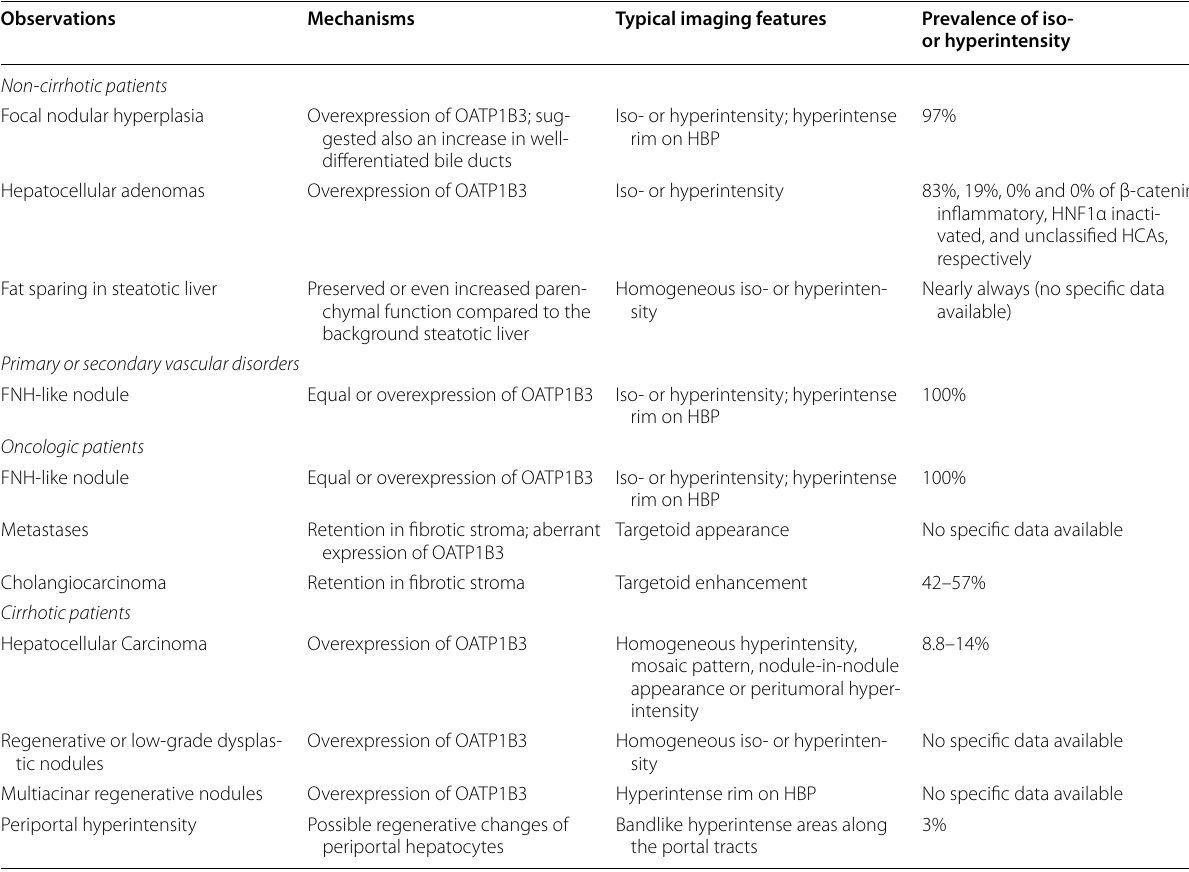
Table 1 Observations, mechanism, typical imaging features and prevalence of iso‑ or hyperintensity